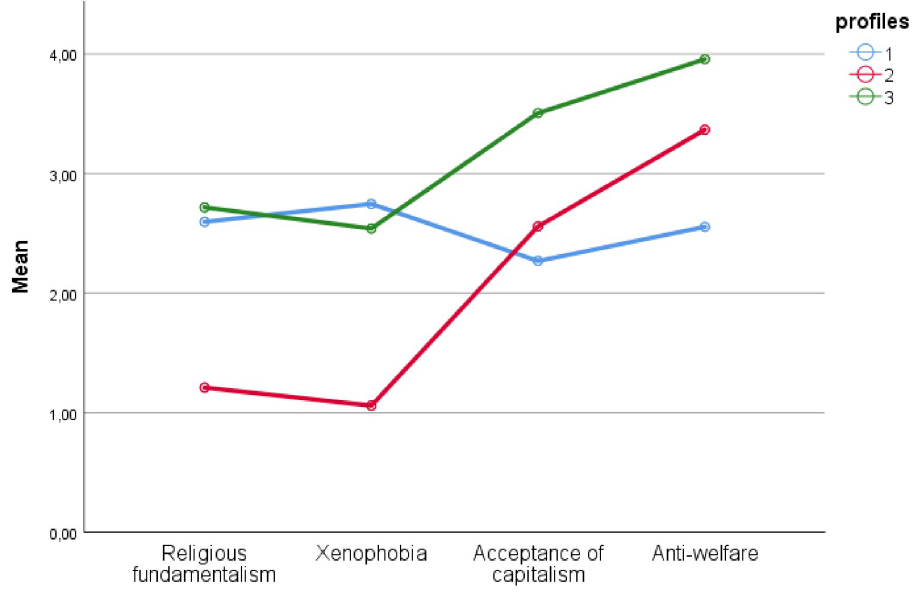
Fig 1. Latent profiles—Three-factor